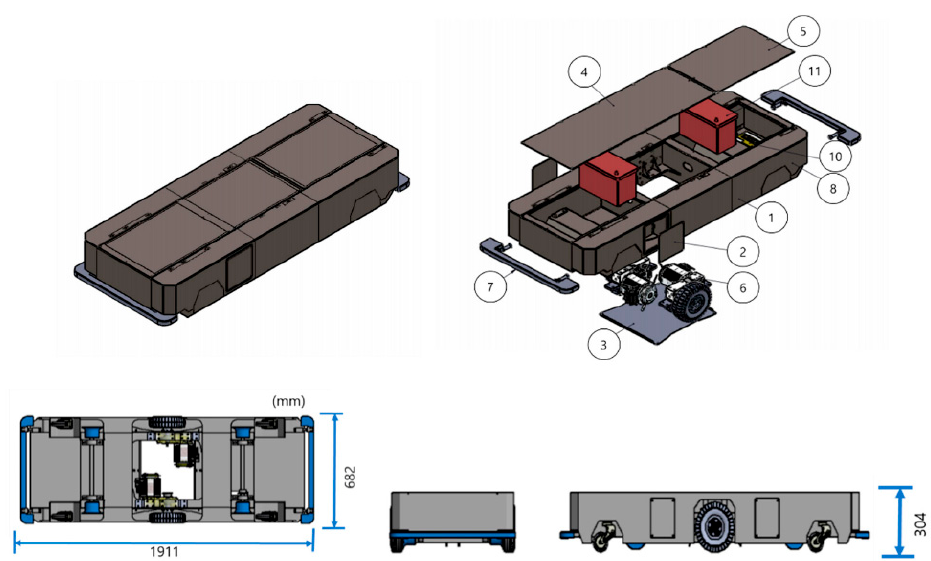
Figure 2. Chassis of the 2WD mobile robot model. (1) frame, (2) cover, (3) cover, (4) cover panel, (5) cover panel, (6) motor, (7) bumper, (8) slide block, (10) sensor cover, (11) battery.